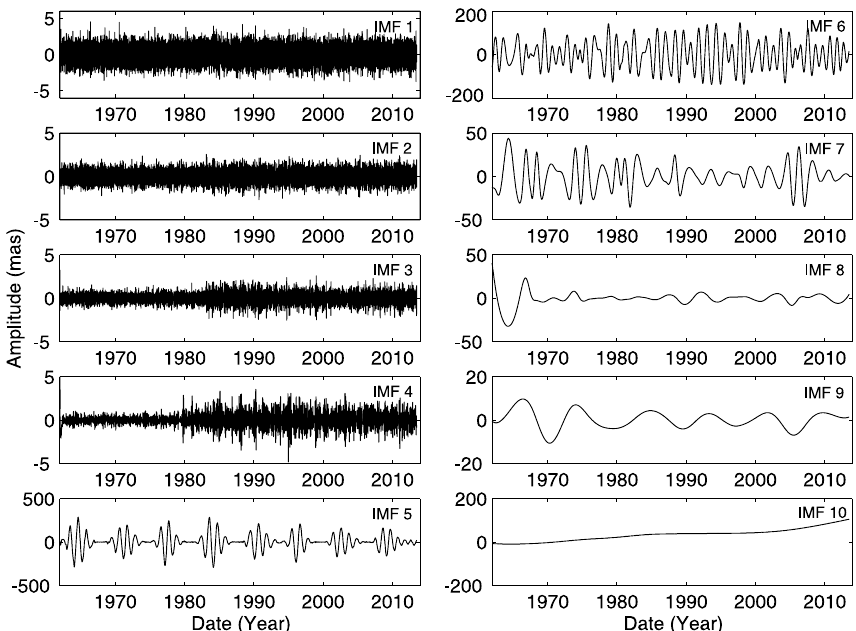
Figure 2. The first 10 IMFs of the x -component of the 1962–2013 PM time series after using EEMD; the last one, IMF11, is a linear term. Here, it is